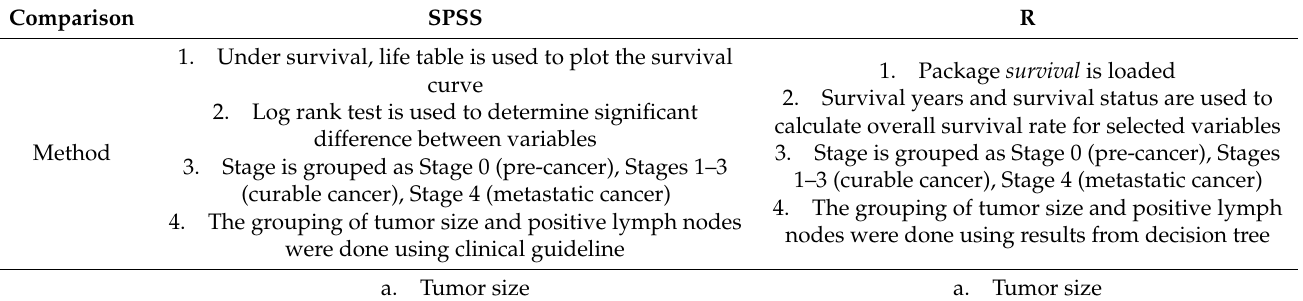
Table 5. Survival analysis comparison using SPSS and R.